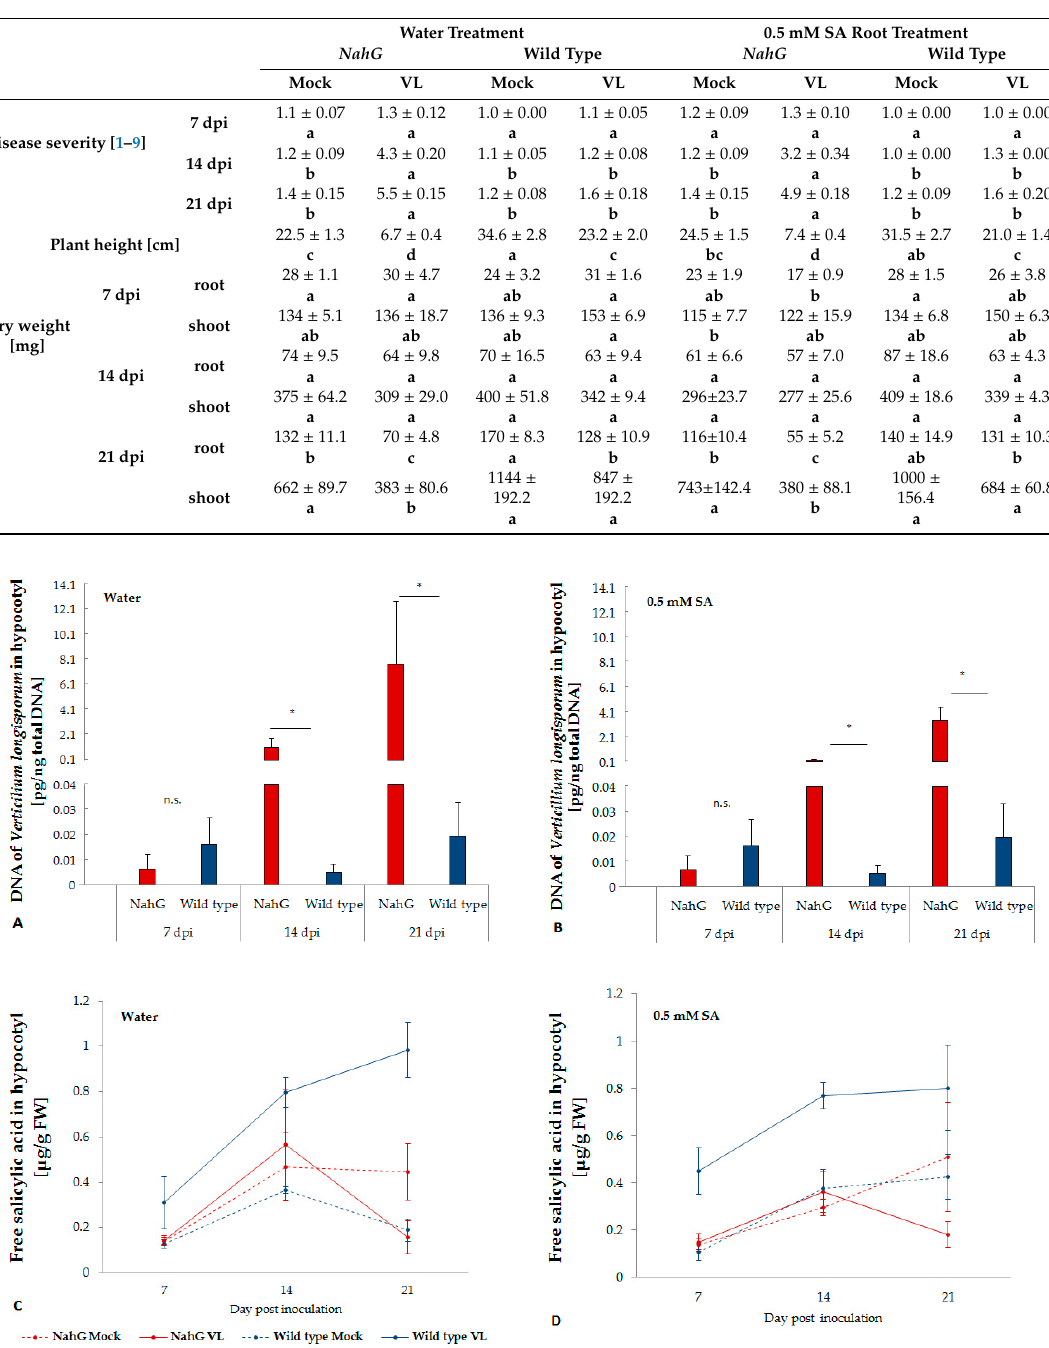
Table 1. Disease severity, plant height and dry weight of mock- and V. longisporum -inoculated oilseed rape. Different letters indicate significant differences within rows for each parameter (LSD test, P < 0.05). SA, salicylic acid; VL, V. longisporum inoculated.